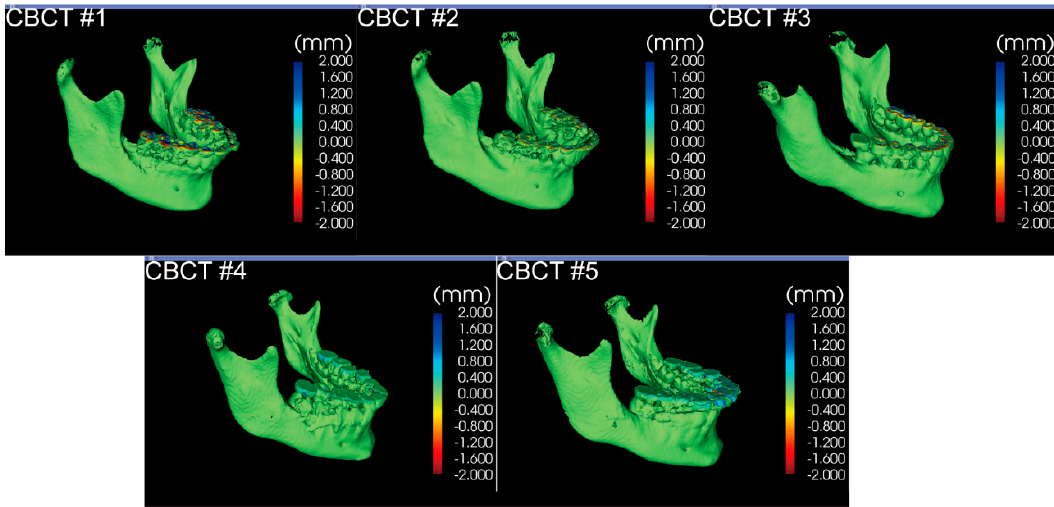
Figure 3. The model-to-model distance analysis in the 3D Slicer software for two segmentations individually performed by two examiners for each CBCT.